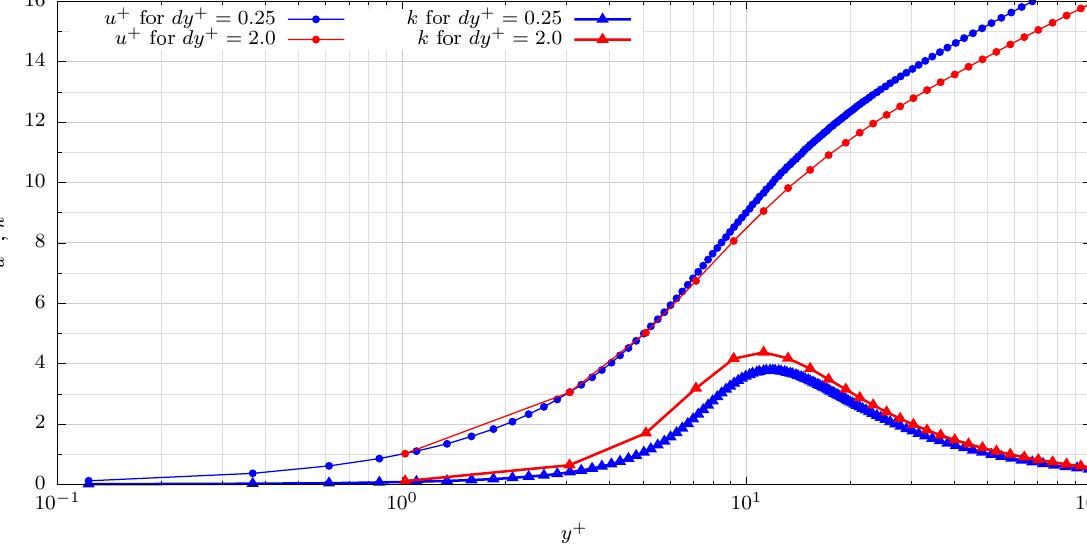
Figure 8: u + and k profiles for the circular pipe from LRN treatment with R C = 10 6 , using different